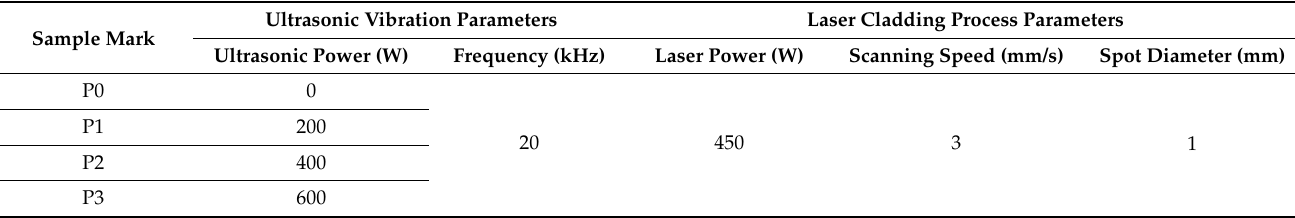
Table 1. Experimental parameters of ultrasonic vibration-assisted laser